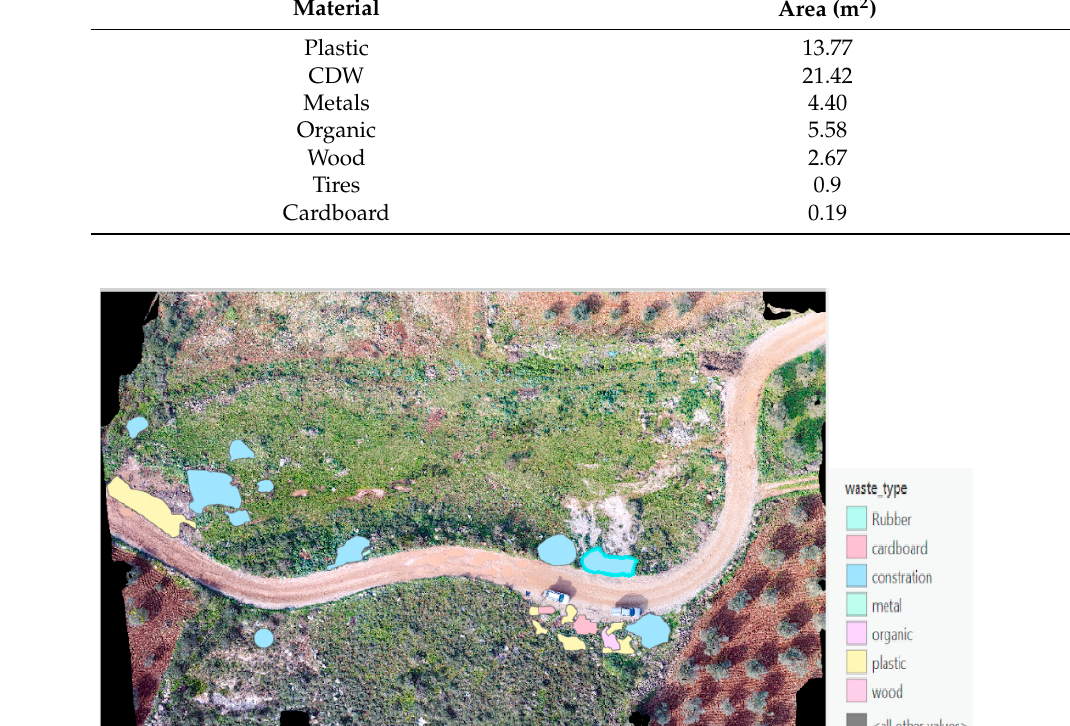
Figure 5. Orthophotos of illegal heterogeneous waste sites. Site #4—mixed waste dump in a larger, spread-out area; area 346.95 m 2 , volume 36.44 m 3 .